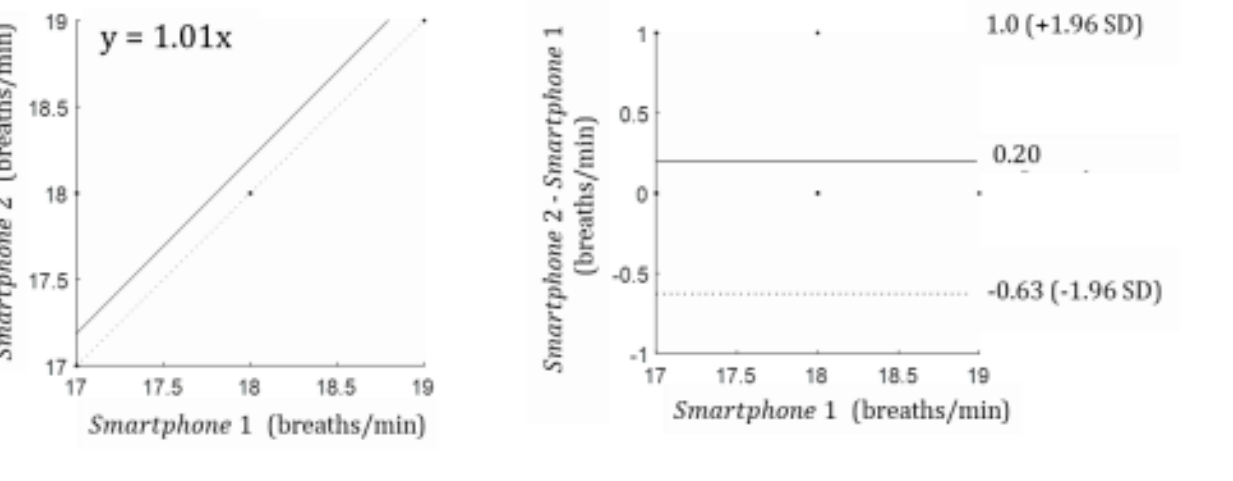
Figure 9. Bland-Altman results according to smartphone type. Smartphone 1: Samsung Galaxy S8; smartphone 2: Samsung Galaxy